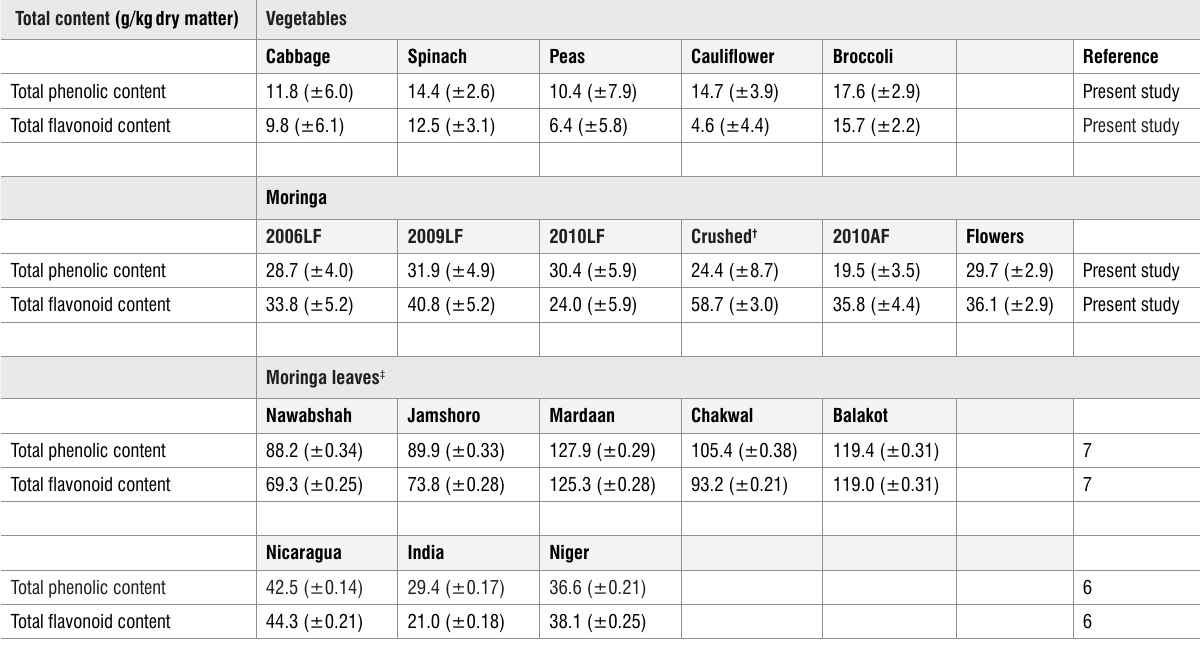
Table 1 : Total phenolic content and total flavonoid content of selected vegetables and Moringa oleifera in this study and reported previously for moringa leaves Total content (g/kg dry